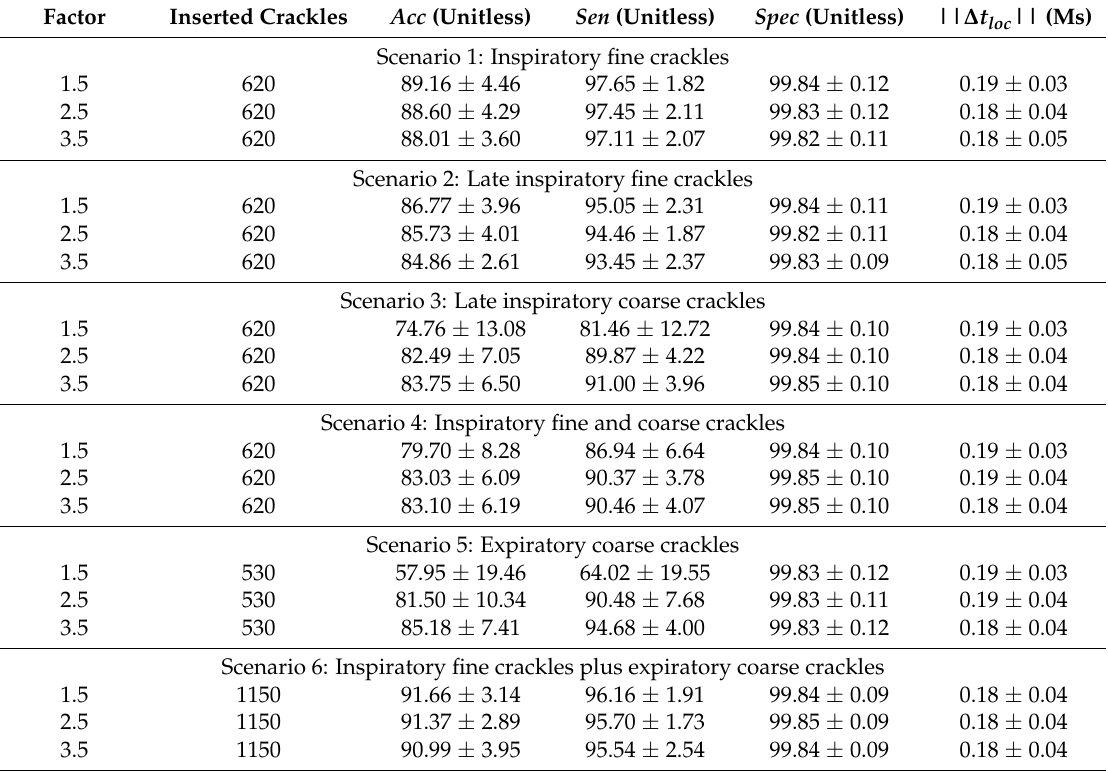
Table 3. Performance indices of the automated crackle detector implemented in the app for all simulated scenarios with inserted crackles to basal respiratory sounds from healthy subjects ( N = 10).